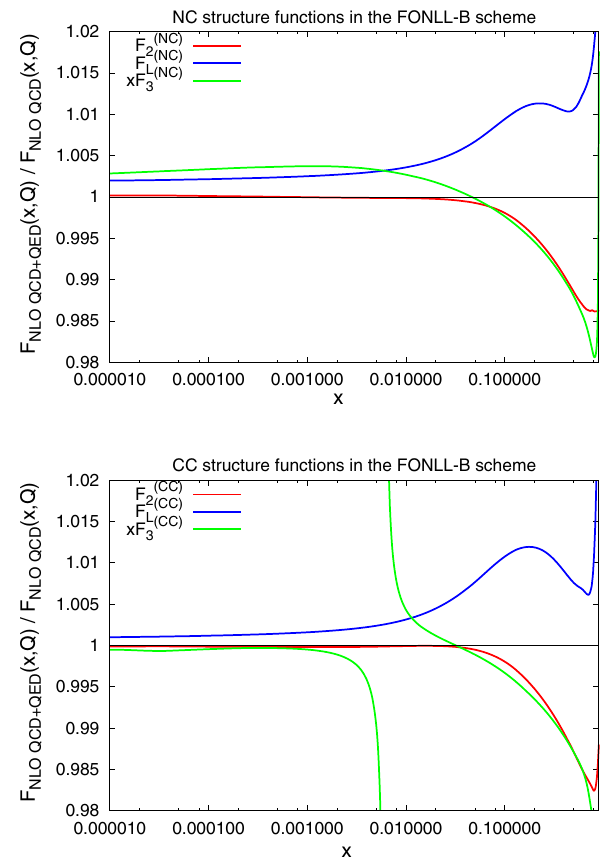
Fig. 13 TheeffectsoftheNLOQEDcorrectionsontheneutral-current ( upper )andcharged-current( lowerplot )DISstructurefunctions F 2 , F L and xF 3 , normalised to the pure QCD results. The calculation has been performed in the FONLL-B general-mass scheme using the central NNPDF3.0QED NLO set as input. Note that QED effects enter both via DGLAP evolution and the O (α) DIS coefficient functions. The behaviour of xF 3 in the lower plot for x ∼ 0 . 007 is explained